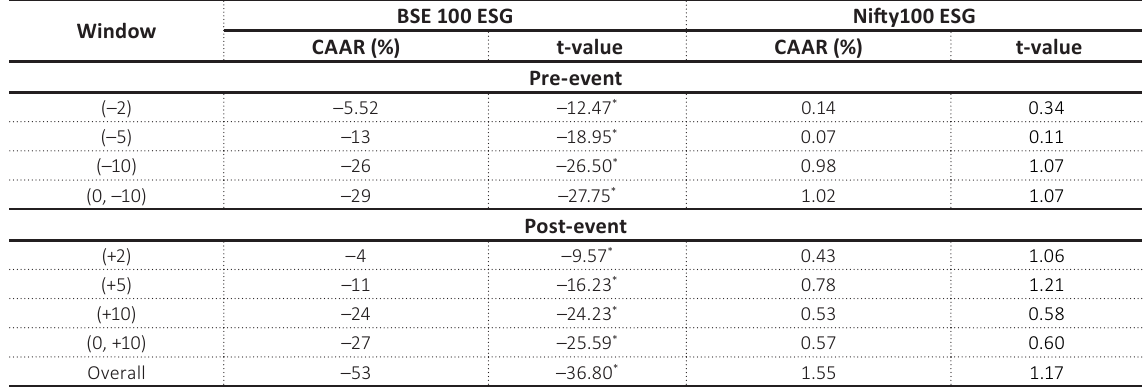
Table 5. Cumulative average abnormal return of BSE ESG 100 and Nifty ESG 100